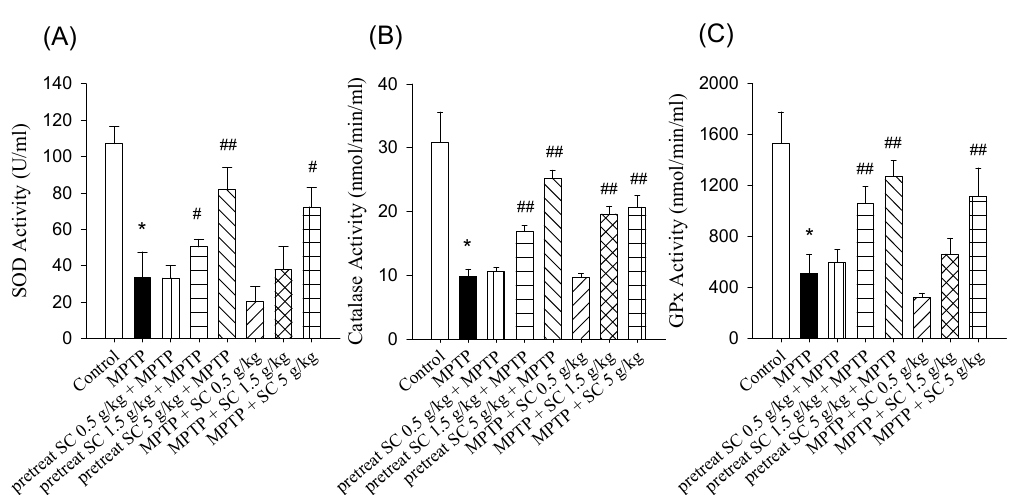
Figure 6. Effects of S. chinensis on the activity levels of SOD, CAT, and GPx in the blood of control and experimental mice. The levels of ( A ) SOD, ( B ) CAT and ( C ) GPx were significantly reduced in the MPTP-only group compared with that in the control group. Pretreatment and treatment with S. chinensis significantly increased the activities of SOD, CAT and GPx in the MPTP + SC group compared with the MPTP-only group. The data are expressed as the mean ± S.D. ( n = 6). * p < 0.001 compared with control group; # p < 0.01 and ## p < 0.001 compared with the MPTP group as determined by T -tests. SOD, superoxide dismutase; CAT, catalase; GPx, glutathione peroxidase; MPTP, 1-methyl-4-phenyl-1,2,3,6-tetrahydropyridine; SC, Schisandra chinensis extract.